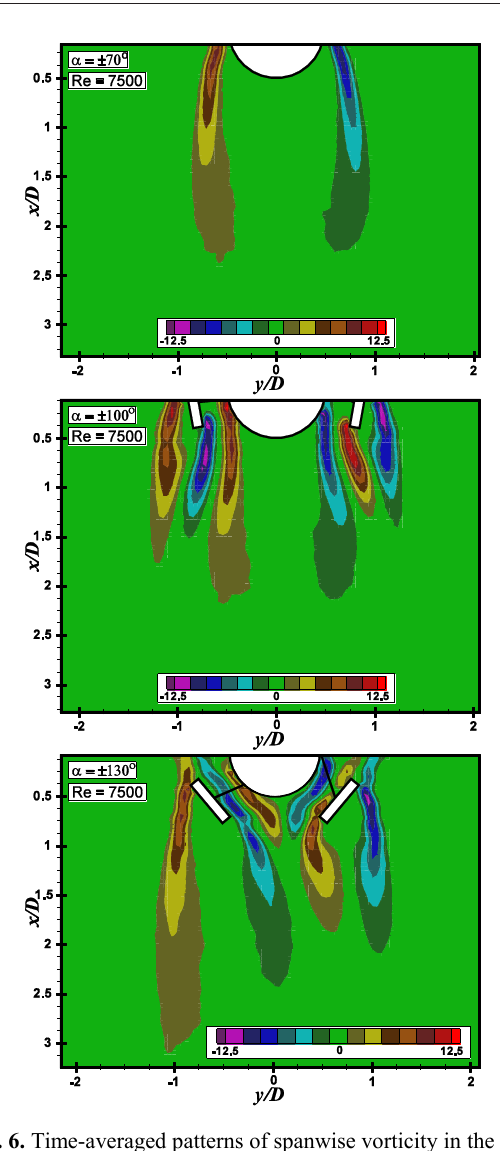
Fig. 6. Time-averaged patterns of spanwise vorticity in the near-wake of the cylinder with and without the guiding plates.